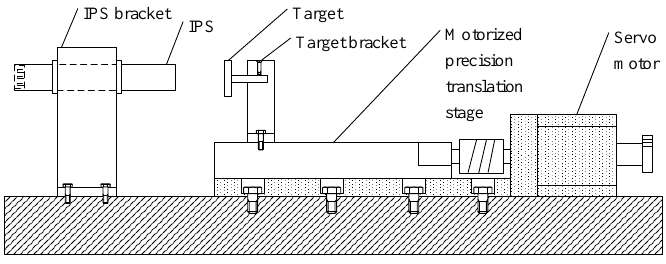
Figure 14. Experimental